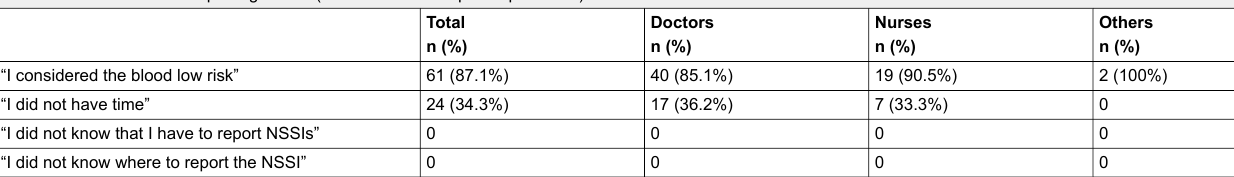
Table 5: Reasons for not reporting NSSIs (more than one response